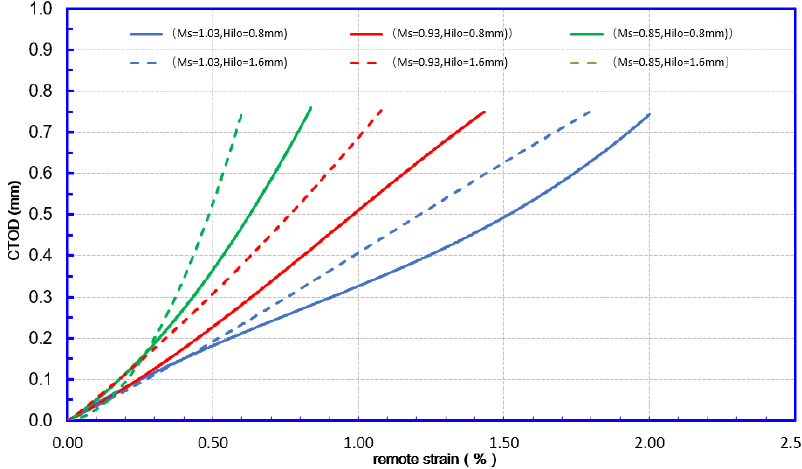
Figure 12. Mismatch effects on CDF 12.8 mm — 12.8 mm WT.